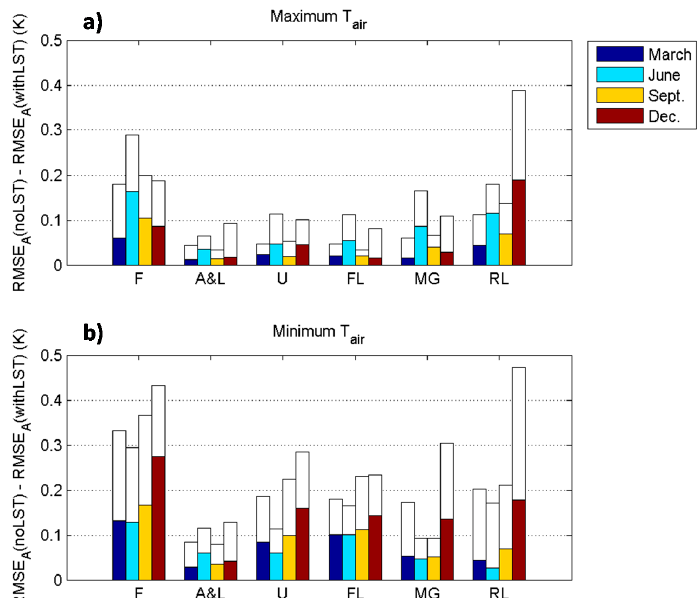
Figure 4. Minimum (white bars) and mean (colored bars) RMSE A of maximum ( a ) and minimum ( b ) T air obtained by considering models including the LST product providing the best estimates (in terms of RMSE A ). Results from regressions for the years 2003–2015 and the following sets of meteorological stations: F: Forests ; A&L: Agricultural and livestock ; U: Urban areas ; FL: Flat lands ; MG: Middle grounds ; RL: Rugged lands .